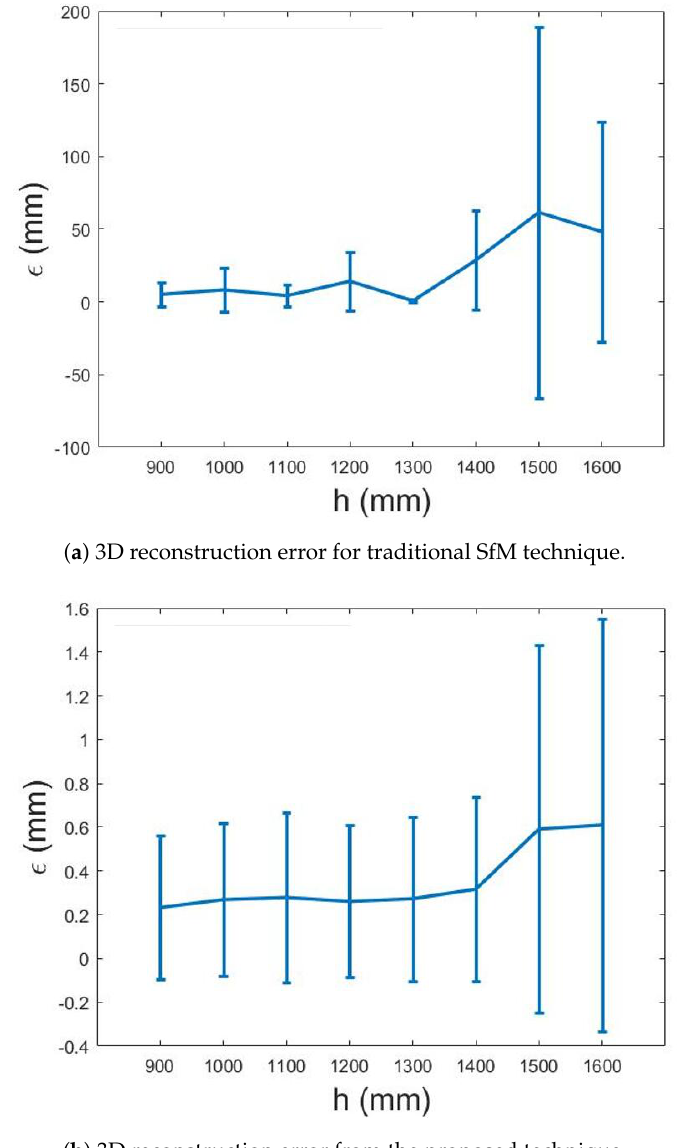
Figure 15. 3D reconstruction error for traditional SfM technique and proposed technique at h = 900,1000,1100,1200,1300,1400,1500,1600